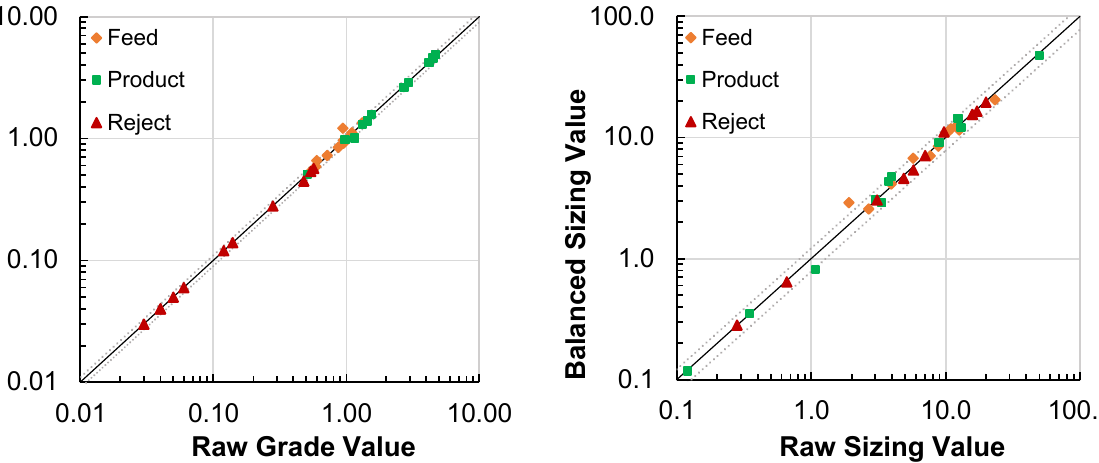
Figure 3. Log–log plot comparing experimental and mass balanced values from Experiment 2-C (0.45 cm/s, z = 9 mm). The dotted lines represent a 95% confidence interval.